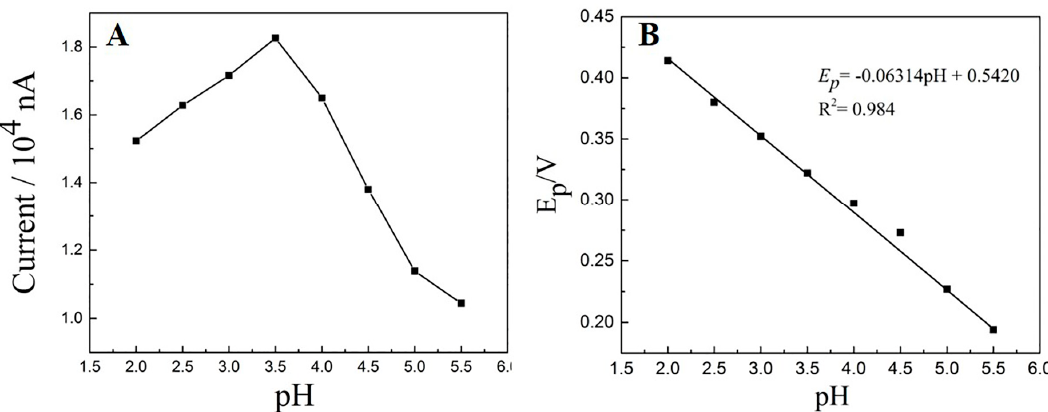
Figure 5. ( A ) The effect of pH on the oxidation peak current of 1 × 10 − 5 mol/L DA; and ( B ) the linear relationship between oxide peak potential and pH.